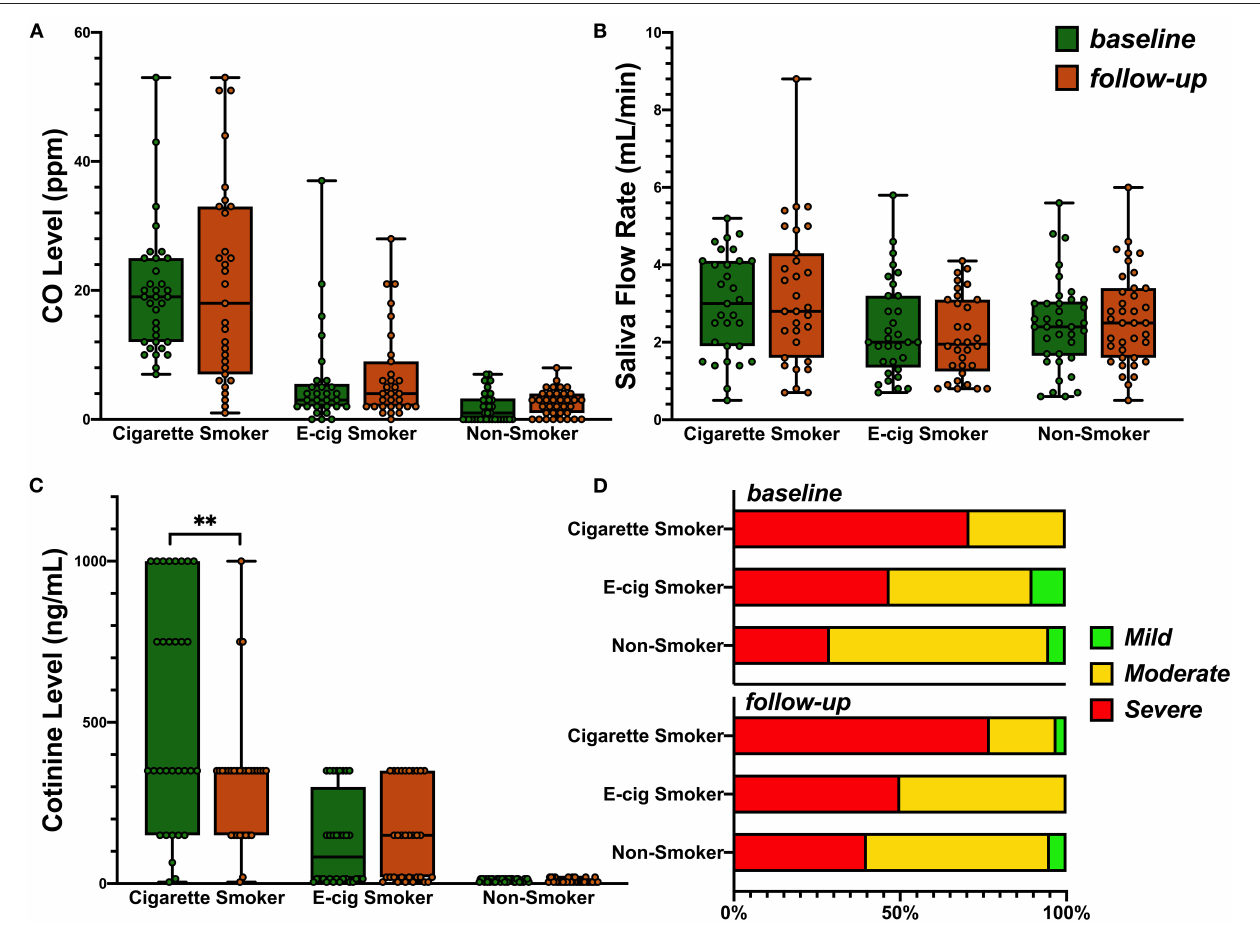
FIGURE 2 | (A) Levels of breath carbon monoxide (ppm) across the subjects in the cigarette smokers, e-cigarette smokers, and the non-smokers at base line and 6-month follow-up: 0–6 ppm, Borderline (BdL): 7–9 ppm, low addicted smoker (LAS): 10–15 ppm, moderate addicted smoker (MAS): 16–25 ppm, heavily addicted smoker (HAS): 26–35 ppm, and very heavily addicted smoker (VHAS): 36 + ppm. Group mean was used for ANOVA ( p < 0.001) as no interaction of time and group was observed. (B) Saliva flow rate in three groups at base line and follow-up. Group mean was used for ANOVA ( p = 0.02) as no interaction of time and group was observed. (C) Distribution of salivary cotinine levels in the participants of the three groups. Kruskal-Wallis test was used and p < 0.001 for both visits. Paired t -test ( p = 0.002) was then used to evaluate the change over time in each group. P value less than 0.01 was summarized with 2 asterisks. (D) Prevalence of periodontal disease in all three groups from baseline to follow-up